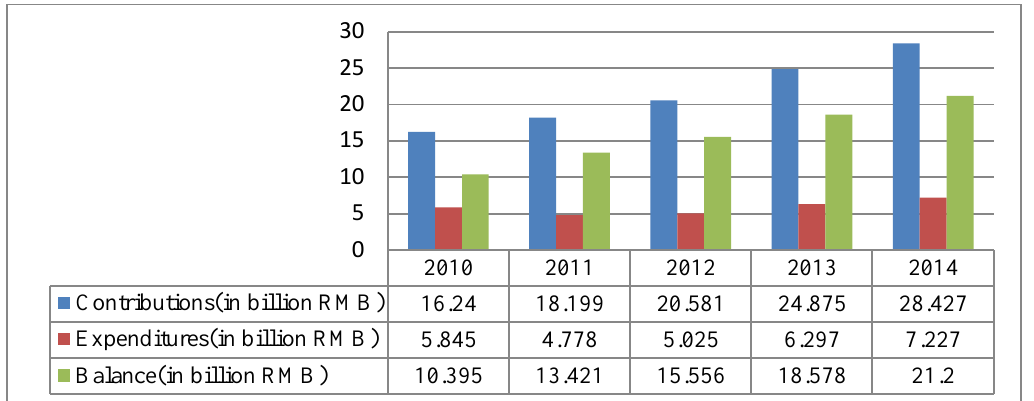
Figure 3. The Contributions, Expenditures and Balance of the Disability Employment Security Fund (2010–2014). Source: Ministry of Finance. Ministry of Finance Annual Statistic in 2010–2014. Ministry of Finance: Beijing, China. Available online: http://www.mof.gov.cn/index.htm (accessed on 3 February 2020) [66].